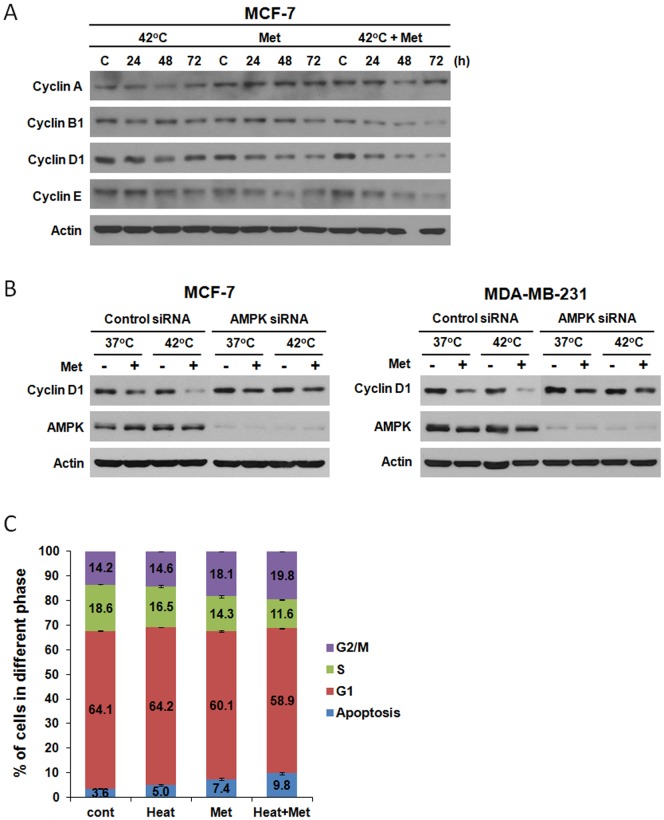
Western blotting of cyclins expression in MCF-7 and MDA-MB-231 cells treated with hyperthermia and metformin.(A) 42°C; Cells were heated at 42°C for 1 h and then incubated at 37°C for 24–72 h. Met; Cells were incubated with or without 5 mM metformin for 24–72 h at 37°C. 42°C + Met; Cells were heated at 42°C for 1 h with or without 5 mM metformin and then incubated at 37°C for 24–72 h. (B) Cells were transfected with AMPK siRNA or control siRNA, and incubated with or without 5 mM metformin for 72 h at 37°C. Effects of 1 h heating at 42°C at the inception for 72 h treatment with or without 5 mM metformin were also studied. Representative results out of several repeated studies are shown. (C) Changes in cell cycle distribution after 42°C heating for 1 h followed by 47 h incubation at 37°C, 48 h treatment with 5 mM metformin at 37°C, or combination of heating and metformin. The increase in G2/M cells, decreased in S cells and increase in apoptotic cells by metformin treatment was statistically significant. The increase in apoptotic cell population in the Heat + Met group as compared with that in Met group was statistically significant.